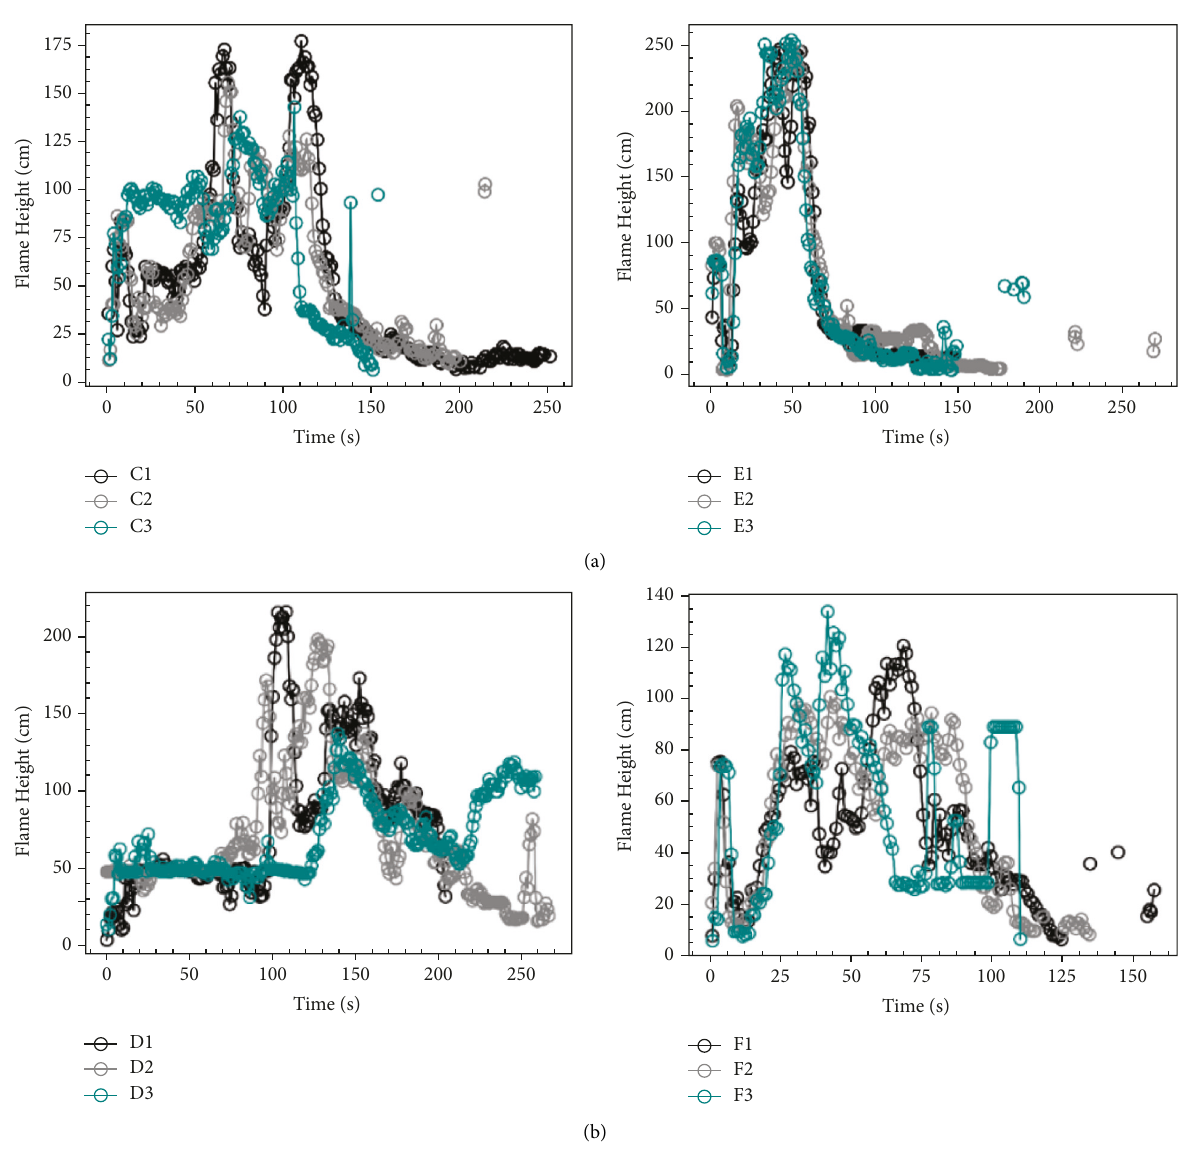
Figure 7: Time evolution of crown flame height in experiments with CBH � 0.7 m under wind conditions. (a) No wind. (b) U � 1m/s. Initial time, t � 0, is set as the time at the transition to the crown layer for each experiment. Experiments C1 and F3 are representative experiments for each experimental